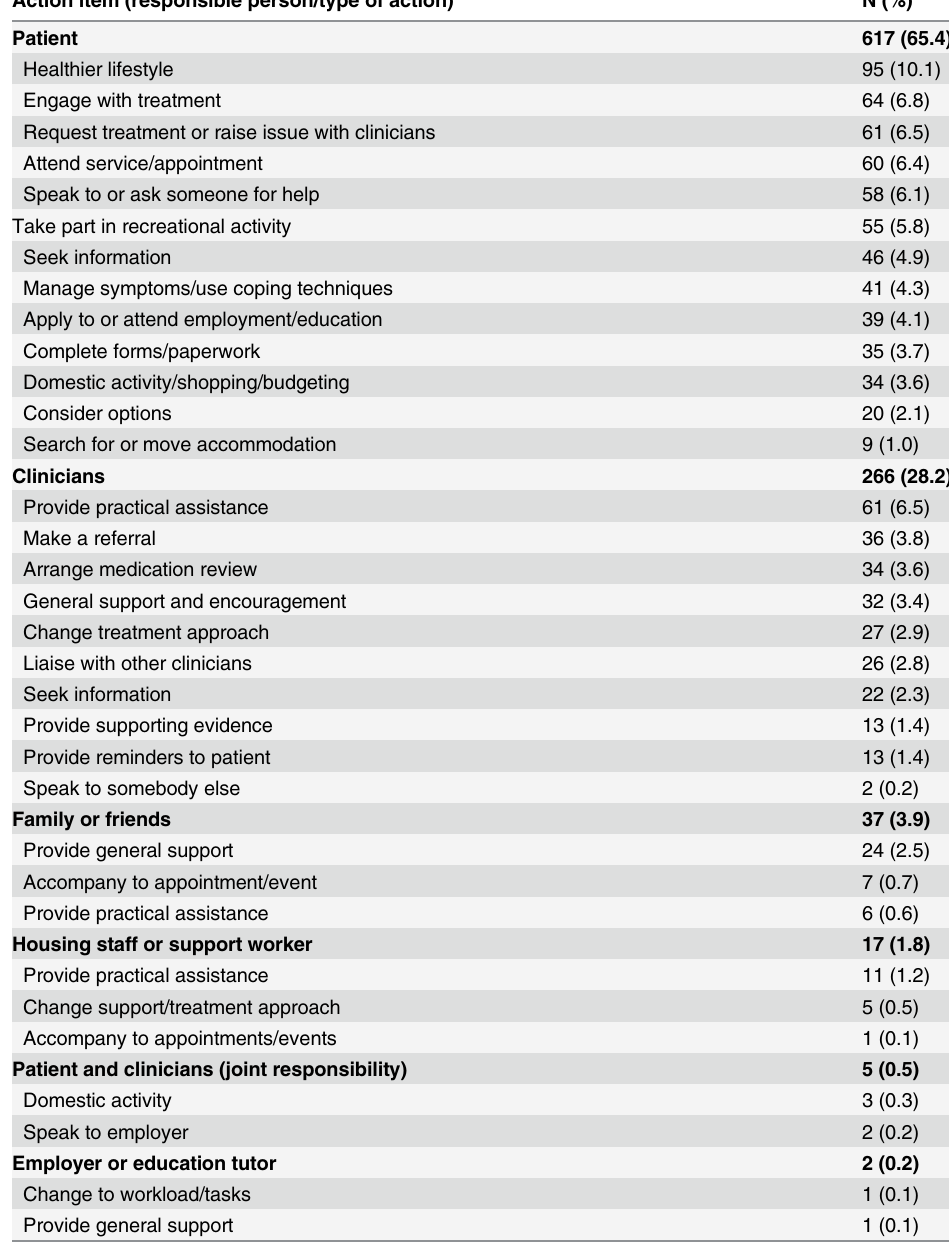
Table 1. The frequency of action items by responsible person and type of